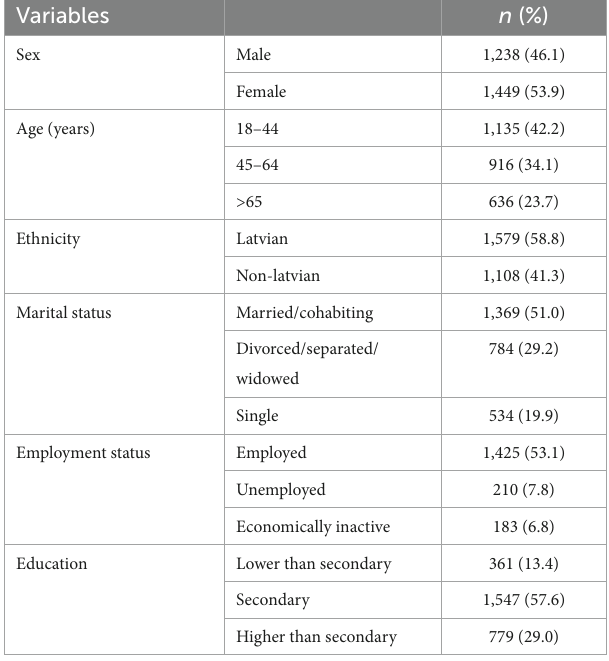
TABLE 1 Sociodemographic characteristics of the total sample ( n = 2,687), weighted